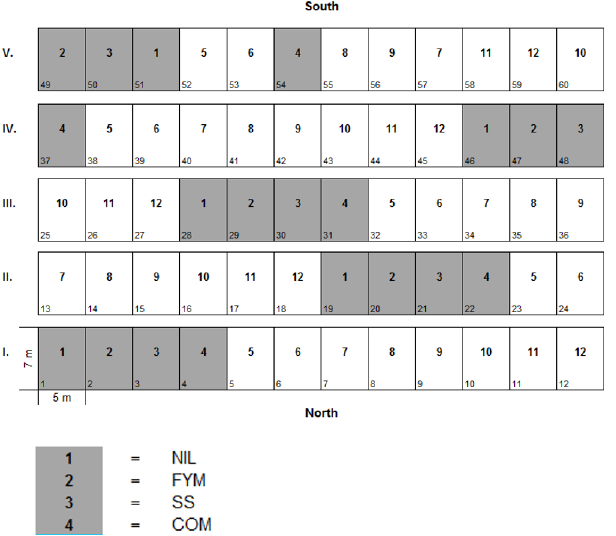
Figure 1. The experimental design of ZOFE, with 12 treatments replicated in five blocks. Only the four treatments highlighted in grey were